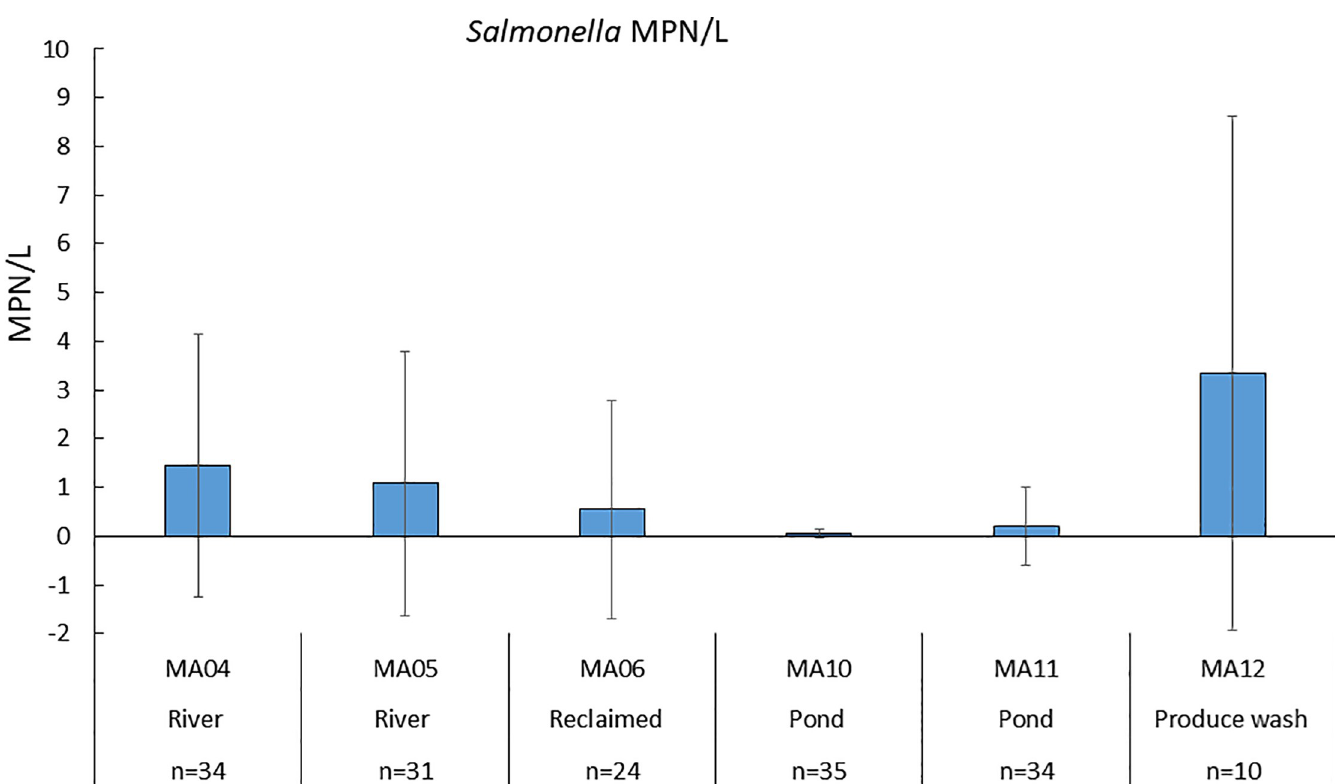
Fig 2. Mean MPN/L values for Salmonella for all six sites (n = number of samples) where water samples were taken from Fall 2016–2018.